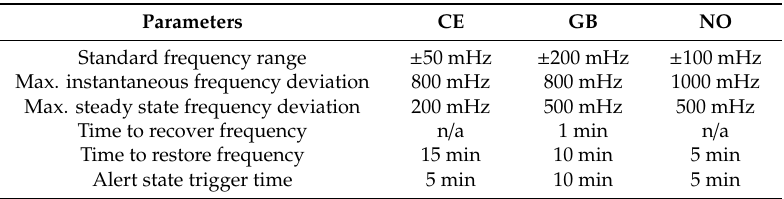
Table 1. Frequency Quality Defining Parameters of the Synchronous Areas (Continental Europe (CE), Great Britain (GB) and Nordic system